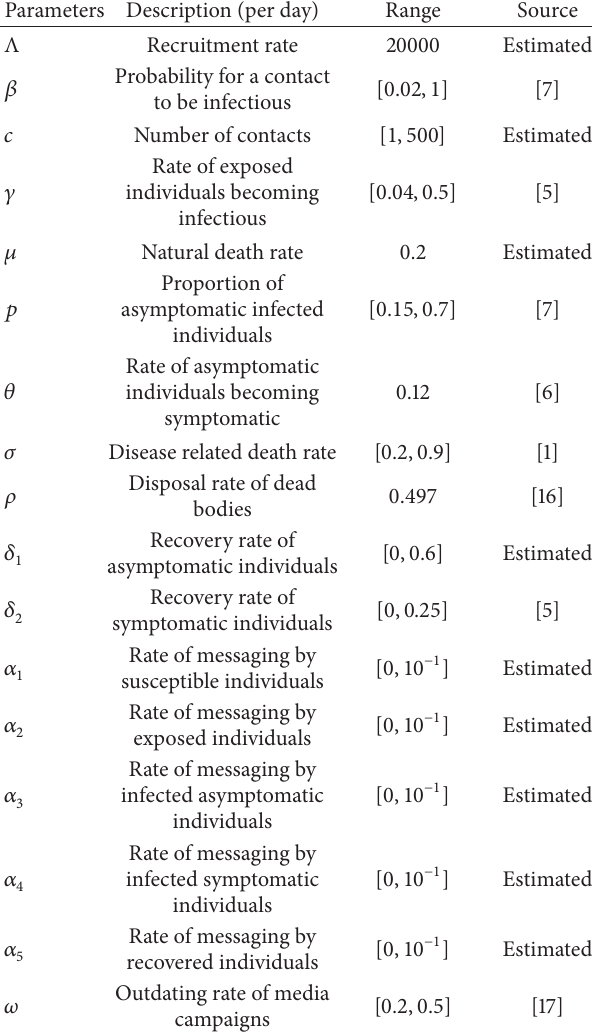
Table 2: Parameter values and their